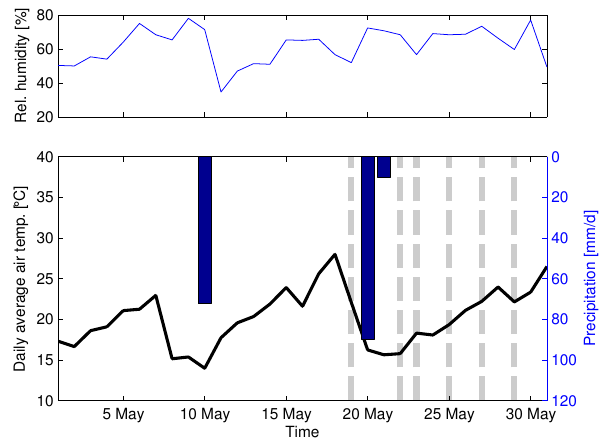
Fig. 4. Weather conditions nearby the study site in May 2011, and the times for GPR survey (dashed grey